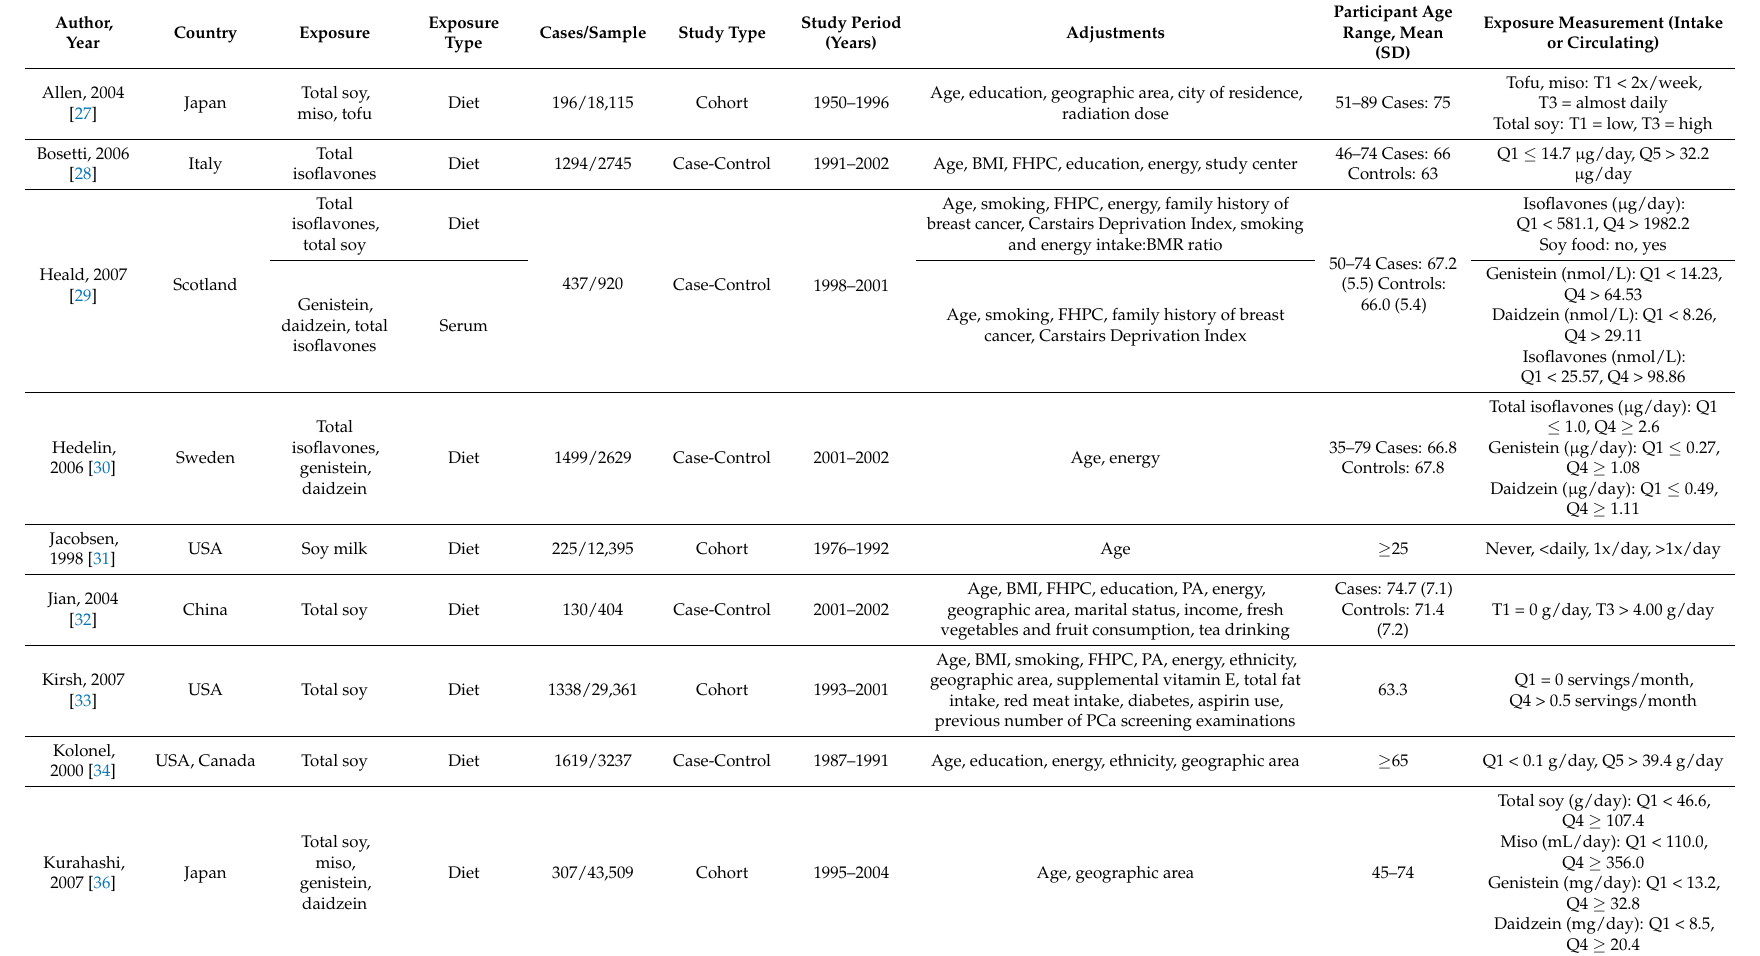
Table 1. Characteristics of included